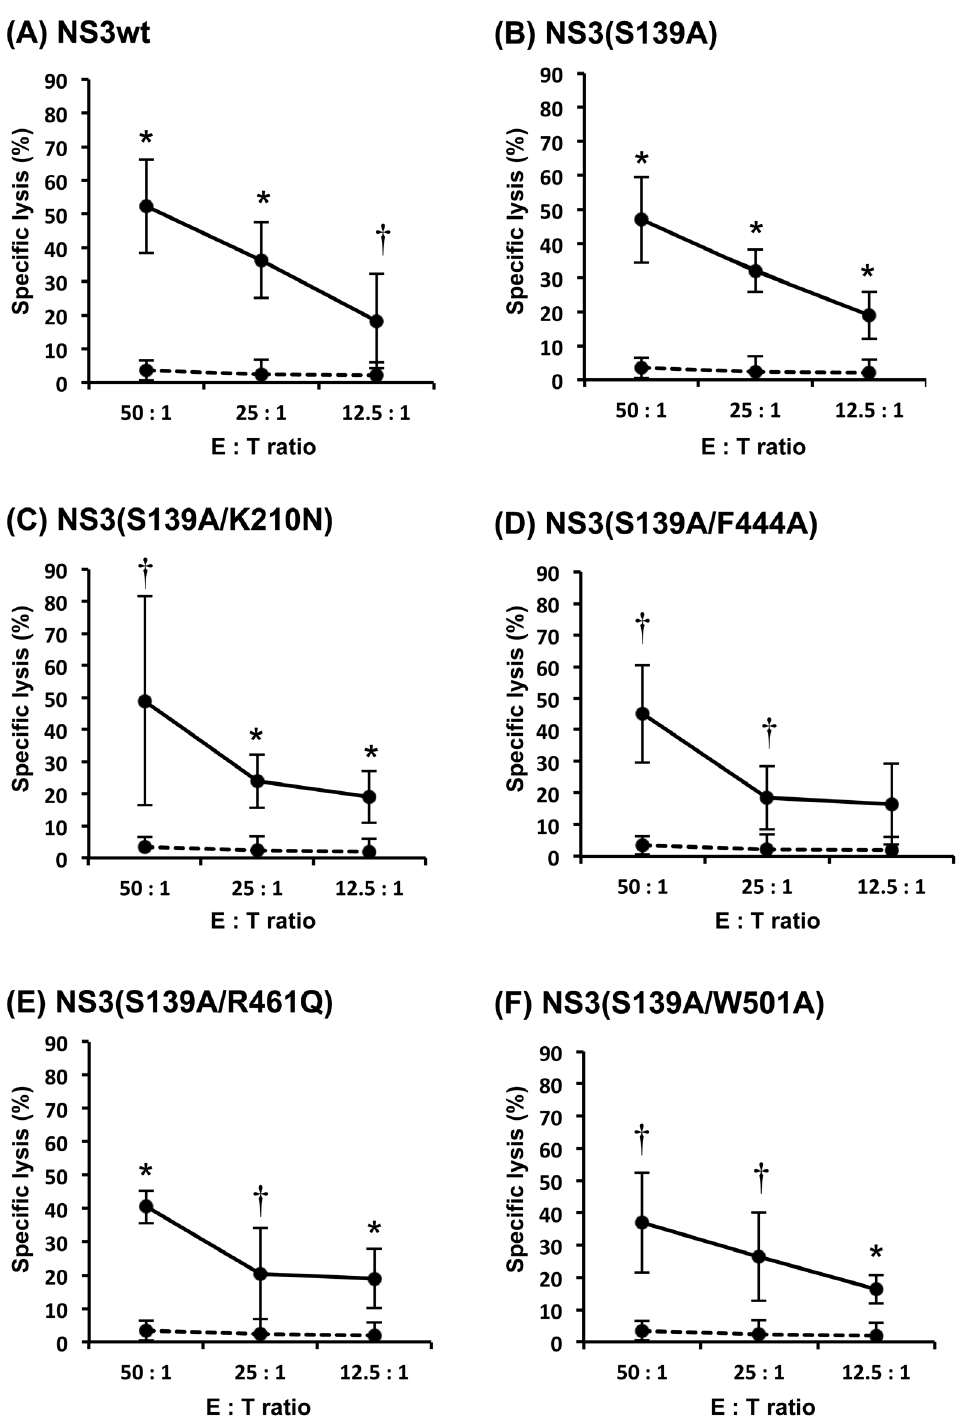
Figure 4. NS3-specific CTL activity induced by DNA vaccination. BALB/c mice (2 mice/group) were immunized with each of the DNA vaccines expressing NS3wt, various NS3 mutants or NS3/4A. Splenocytes obtained from the immunized mice were stimulated in vitro for 5 days with P815-NS3 cells and GST-NS3wt (5 m g/ml). Effectors and targets (P815-NS3) were cocultured for 4 h with the ratios of 50:1, 25:1, and 12.5:1. Released LDH was measured and the percentage of specific killing was calculated. Specific CTL activity of splenocytes obtained from NS3-immunized mice and the mock-immunized control are shown with solid and dashed lines, respectively. Data represent mean 6 SEM of the data from three independent experiments. *, p , 0.01; { , p , 0.05, compared with the mock-immunized control.